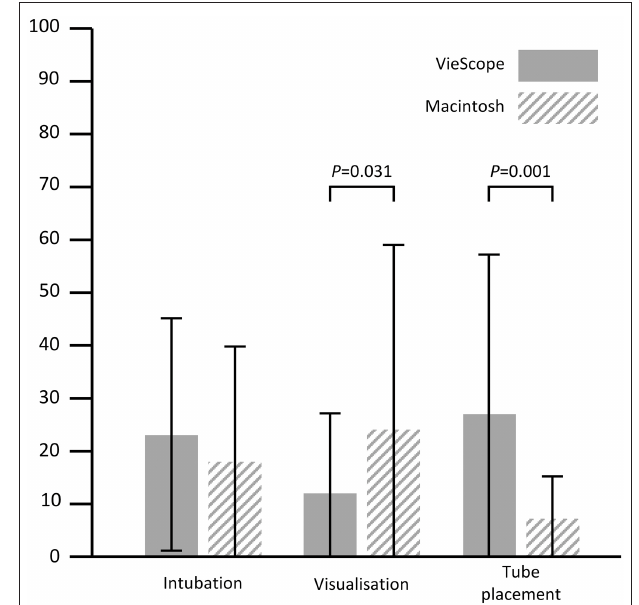
FIGURE 3 | Intubation difficulty ratings on visual analog scales. All items rated on visual analog scales (0–100, lower values better); intubation: overall difficulty of intubation; visualization: difficulty to obtain adequate view on larynx; Tube placement: difficulty of advancing tube into trachea; Error bars indicate standard